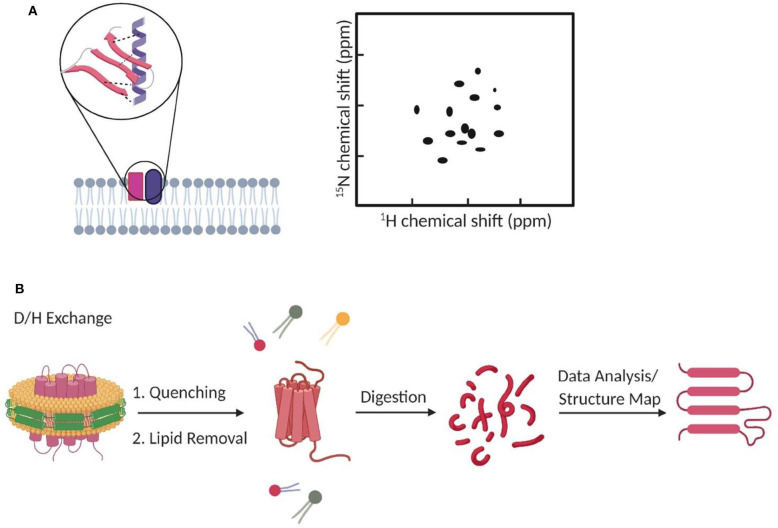
The use of NMR and mass spectrometry for studying membrane transient interactions. (A) Dynamic membrane protein structural changes and interactions can be analyzed from the observed chemical shifts in 2D NMR spectrum. (B) Schematic of a general HDX-MS workflow to study protein conformation changes induced by dynamic lipid–protein interactions.